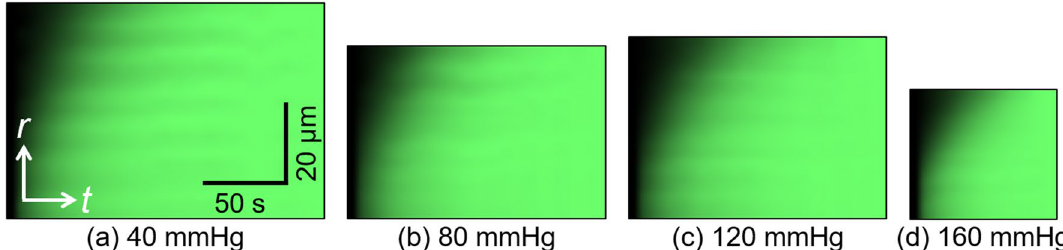
Figure 4. Kymograph of fluorescent dye solution at intraluminal pressures of ( a ) 40, ( b ) 80, ( c ) 120, and ( d ) 160 mmHg. t , time axis; r , radial axis. These images were obtained from the images shown in Fig. 3. The image was created using ImageJ 1.52a.